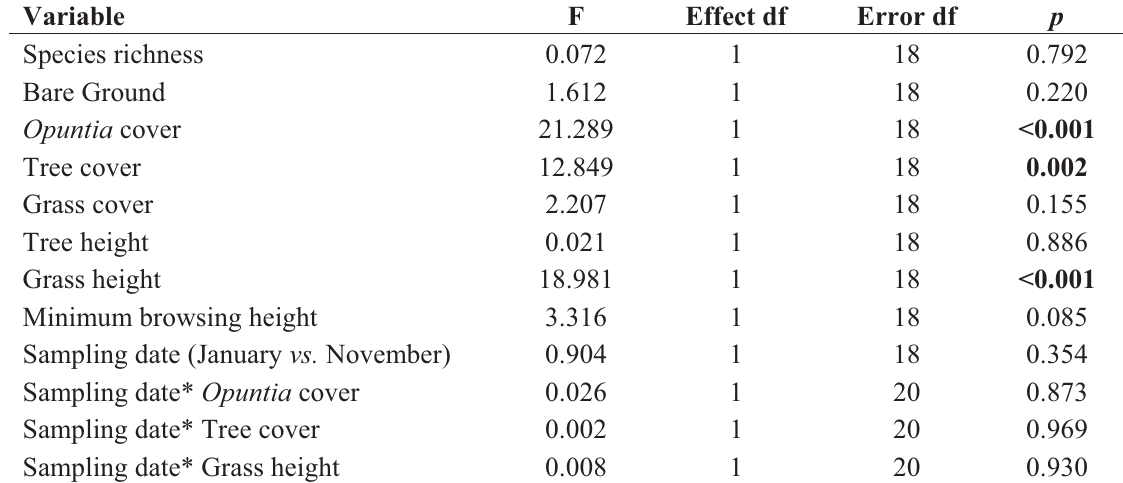
Table 2. Results of the General Discriminant Analysis performed to test for differences in habitat structure between East and West RF Guembeul. The interaction between sampling dates (January vs. November) and the three significant variables are also